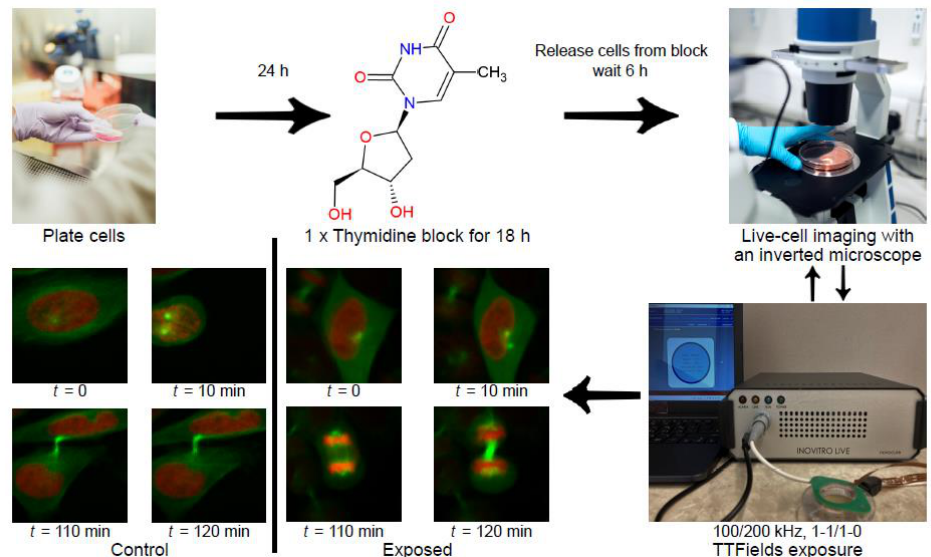
Figure 3. A schematic of the full procedure used in our live-cell imaging experiments with TTFields- exposed cells. The microscope images of exposed HeLa cells shown here were obtained in our experiments with 100 kHz TTFields with a 1-1 duty cycle.